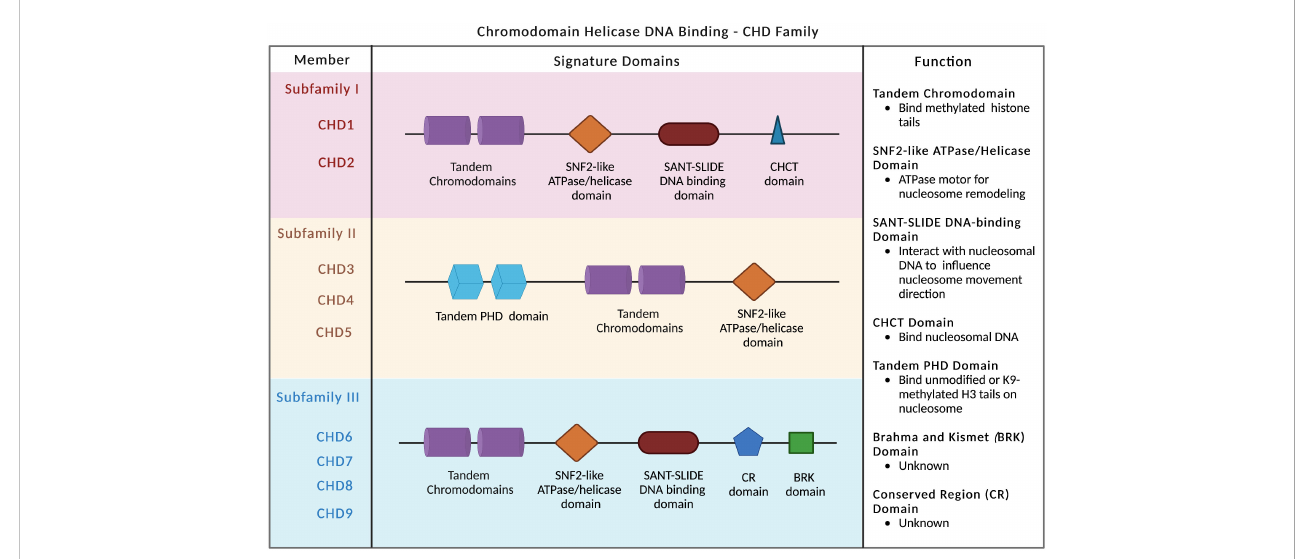
FIGURE 1 CHD family and signature domains. Three subfamilies of CHD chromatin remodelers are presented with signature domains. The major functions of each domain are